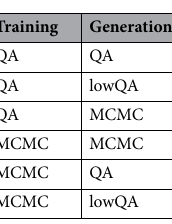
Table 2. Combinations of sampling methods for training and generation. Gibbs sampling is denoted by MCMC, and lowQA denotes QA with the lowest energy states.